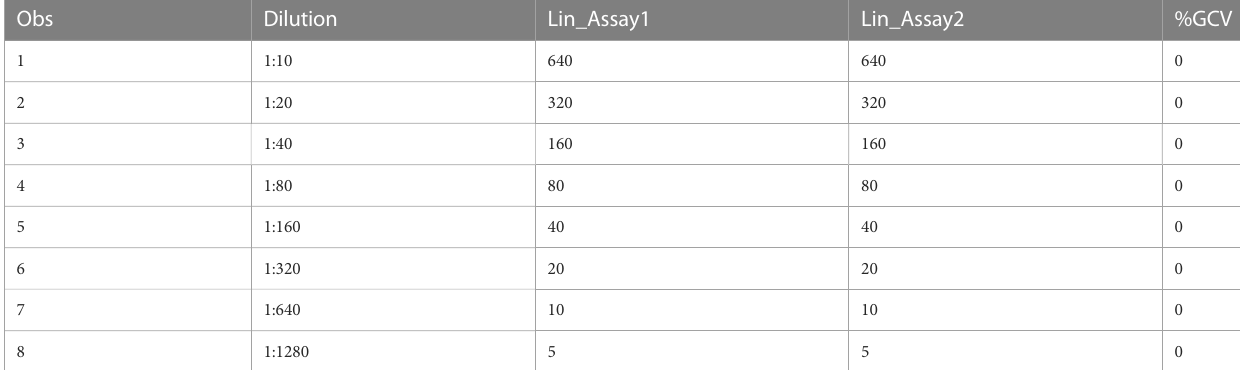
TABLE 6A HAI assay quali fi cation on H3N2 in fl uenza strain A/Texas/71/2017, range testing, %GCV IP results from linearity assays.